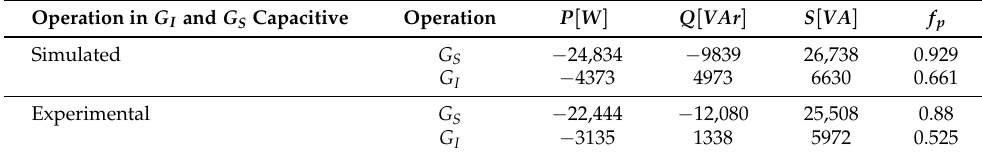
Table 9. Operation in G I and G S